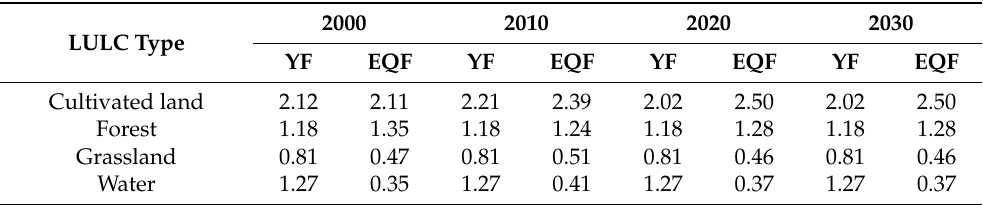
Table 3. Values of YF and EQF in different years in the study area. 2000 2010 LULC Type YF EQF YF EQF YF EQF YF EQF Cultivated land 2.12 Forest Grassland 0.81 0.47 0.46 Water